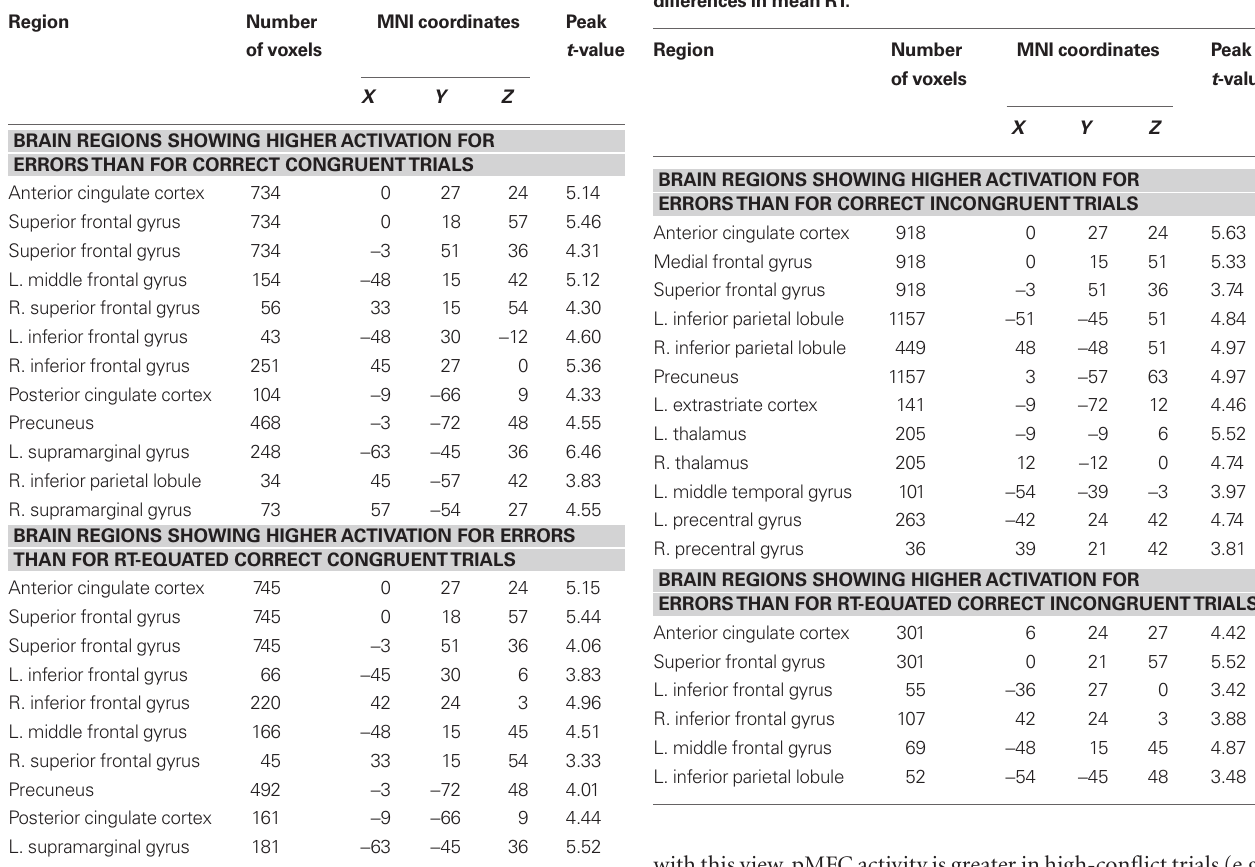
Table 2 | Differences in brain activity between errors and correct congruent trials before and after controlling for conditional differences in mean RT.